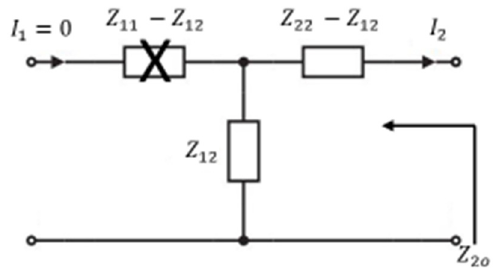
Figure 10. Second measurement.